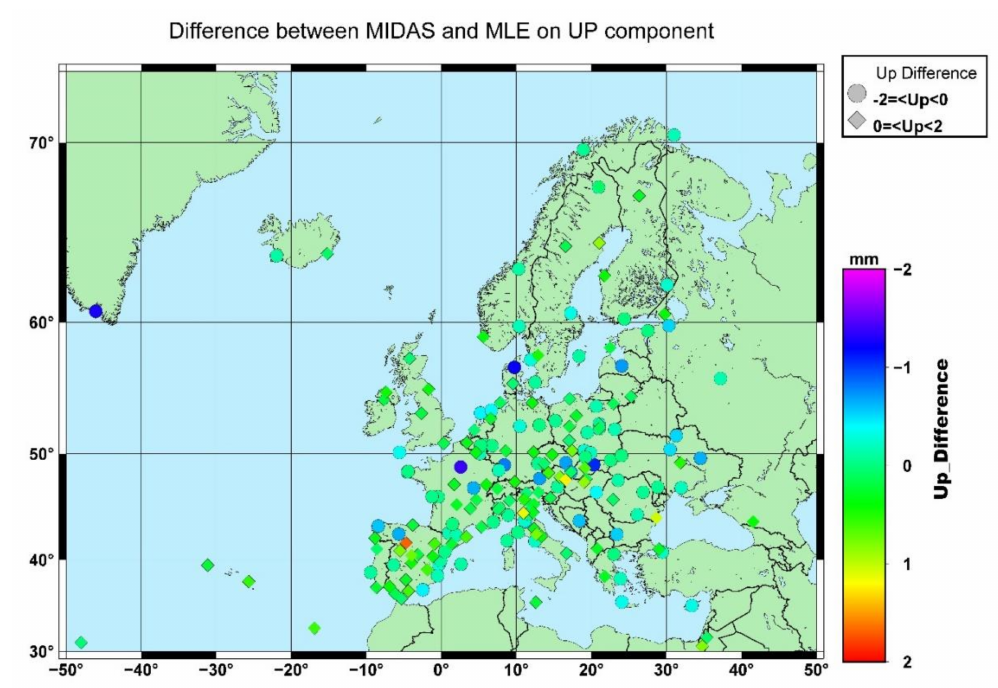
Figure 11. Stations’ velocity difference between MIDAS and MLE for the Up component.